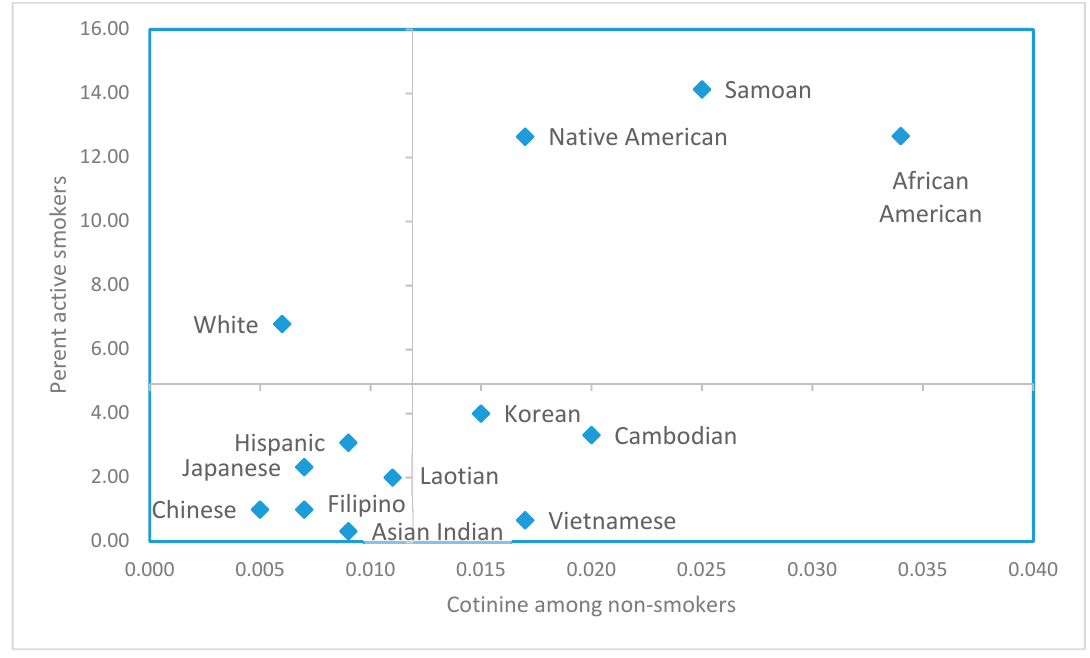
Figure 1. Percent active smokers (N = 3329); vs geometric mean serum cotinine levels in non-smokers (N = 3180); prenatal screening program enrollees in 13 race/ethnic groups; San Diego, Orange and Imperial counties. (Smoking status defined by race- and age-specific cutpoints per Benowitz et al. 2008 [39]. Grid lines show the mean of percent active smokers in the 13 race/ethnic groups and the antilog of the mean log cotinine in non-smokers in the 13 groups.)